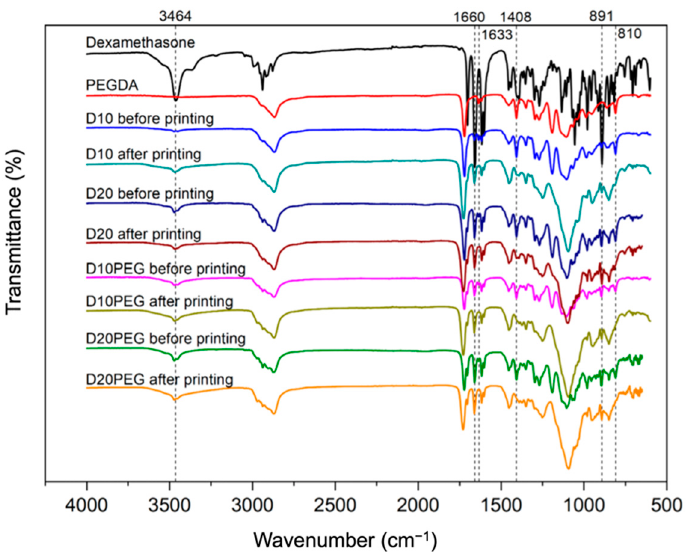
Figure 7. FTIR spectra of dexamethasone, PEGDA, and different formulations before and after DLP 3D printing.